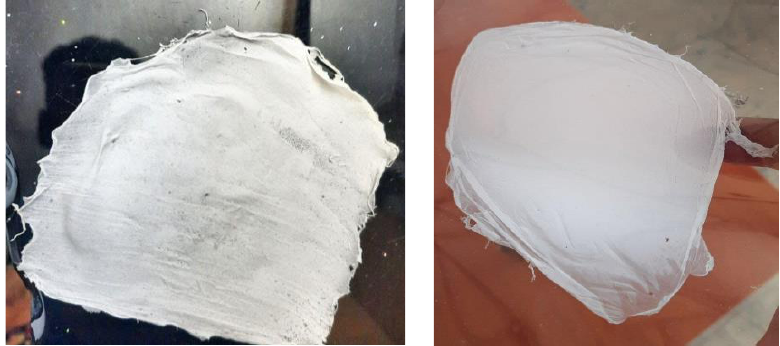
Figure 2: The Sample of